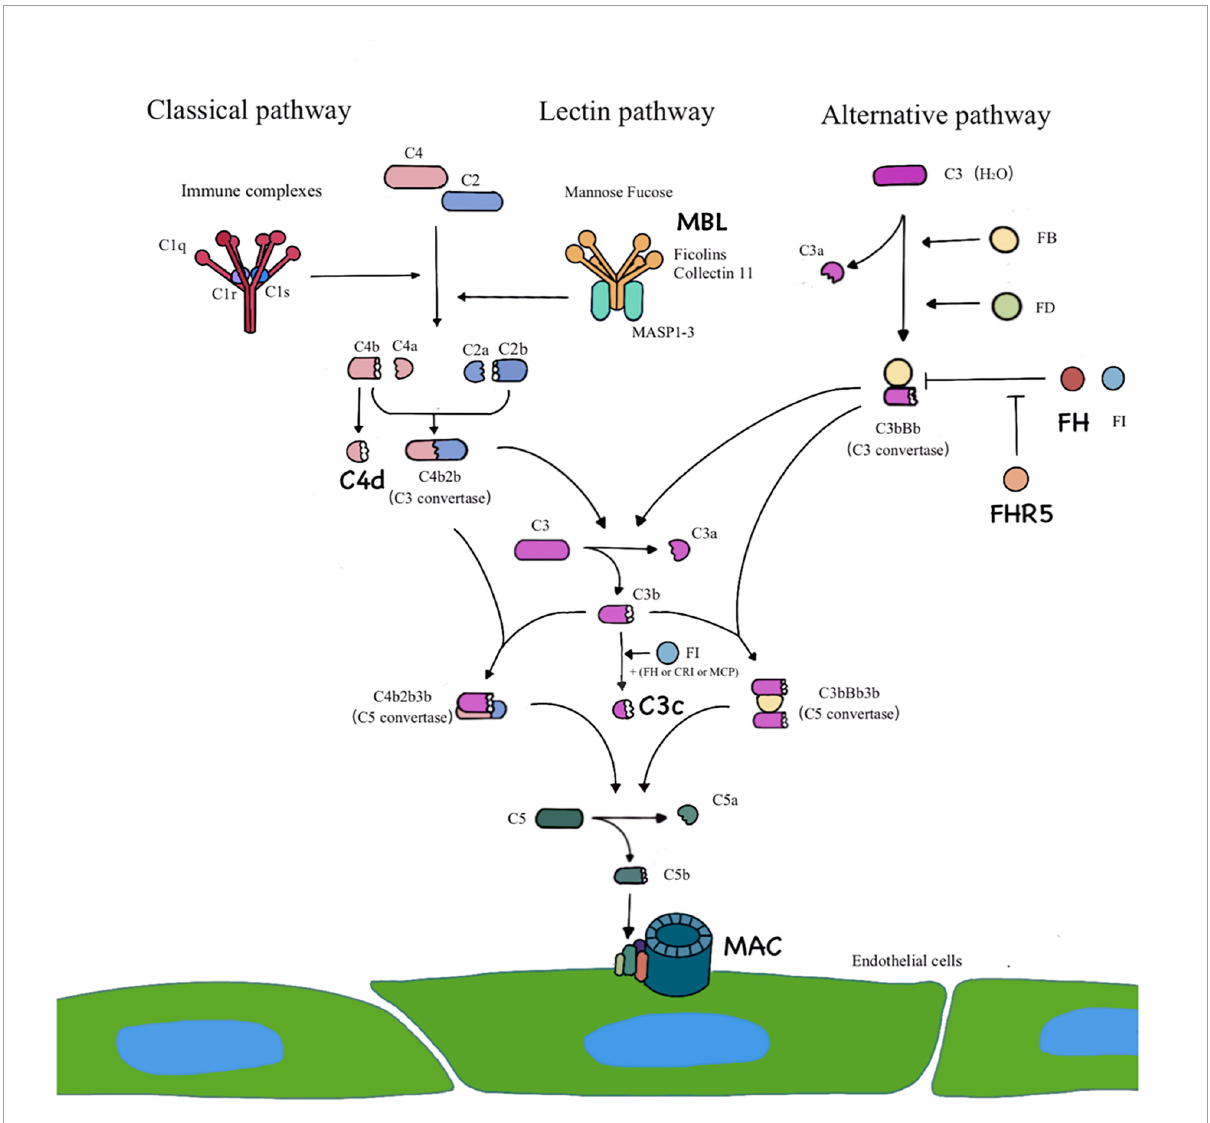
FIGURE1 Three pathways of complement activation. The classical pathway is activated by IgG– and/or IgM–containing immune complexes. The lectin pathway requires a particular sugar moiety pattern to be recognized and bound by MBL/Ficolins/Collectin 11, leading to a classical pathway–like activation cascade. C4d represents the activation of classical pathway or/and lectin pathway. The alternative pathway is constantly initiated by spontaneous hydrolysis of C3 [C3b (H 2 O)] that is efficiently powered by the covalent attachment of C3b on an activating surface. Complement factor H (FH) and factor H related protein 5 (FHR5) are regulator proteins of alternative pathway. Three pathways lead to formation of C3 convertase and converge at the C3 level. The addition of C3b to the C3 convertase creates C5 convertase, which triggers the formation of the terminal pathway complete complex (C5b-9), which is also known as membrane attack